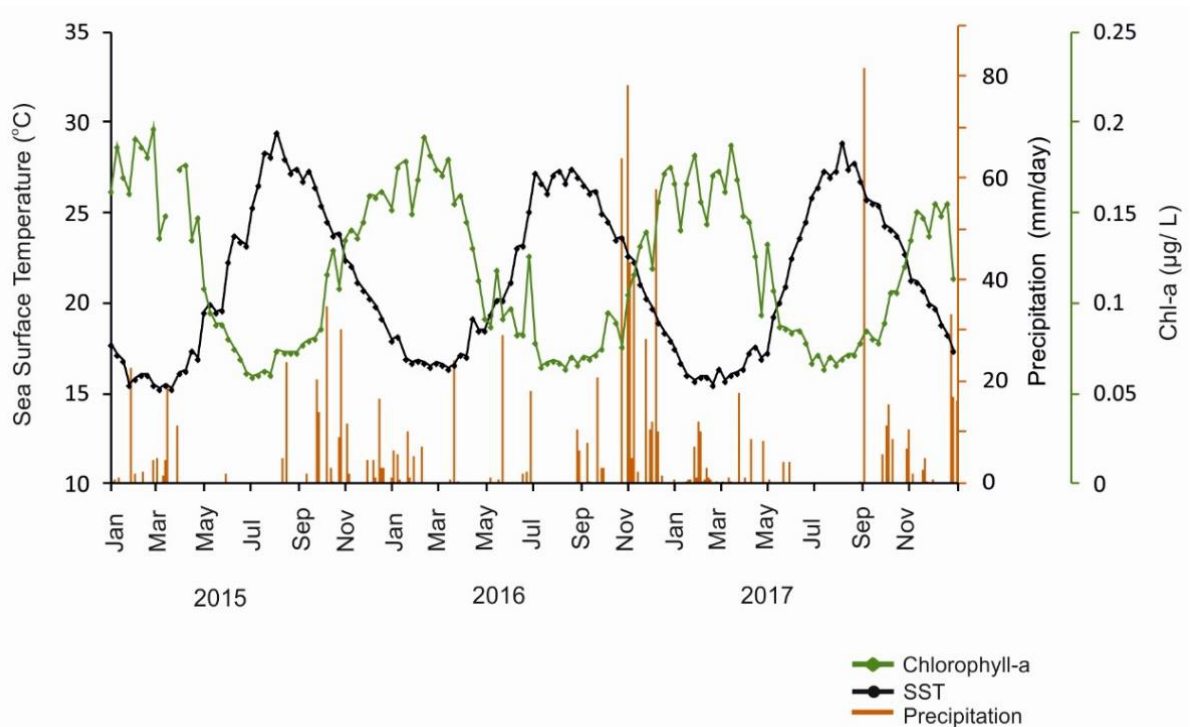
Figure 2. Satellite-derived data of the study area’s SST, chlorophyll-a, and precipitation variations during the studied time interval. (Obtained from http://disc.sci.gsfc.nasa.gov/techlab/giovanni/ accessed on 11 October 2022) (all analyses of this study were produced with the Giovanni online data system that is developed and maintained by the NASA GES DISC).